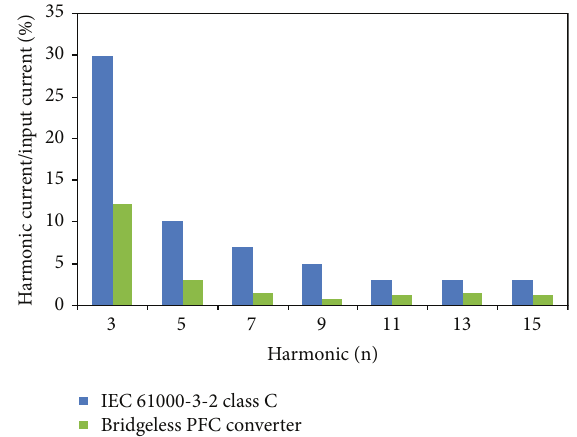
Figure 11: Measured harmonic contents of the proposed converter.